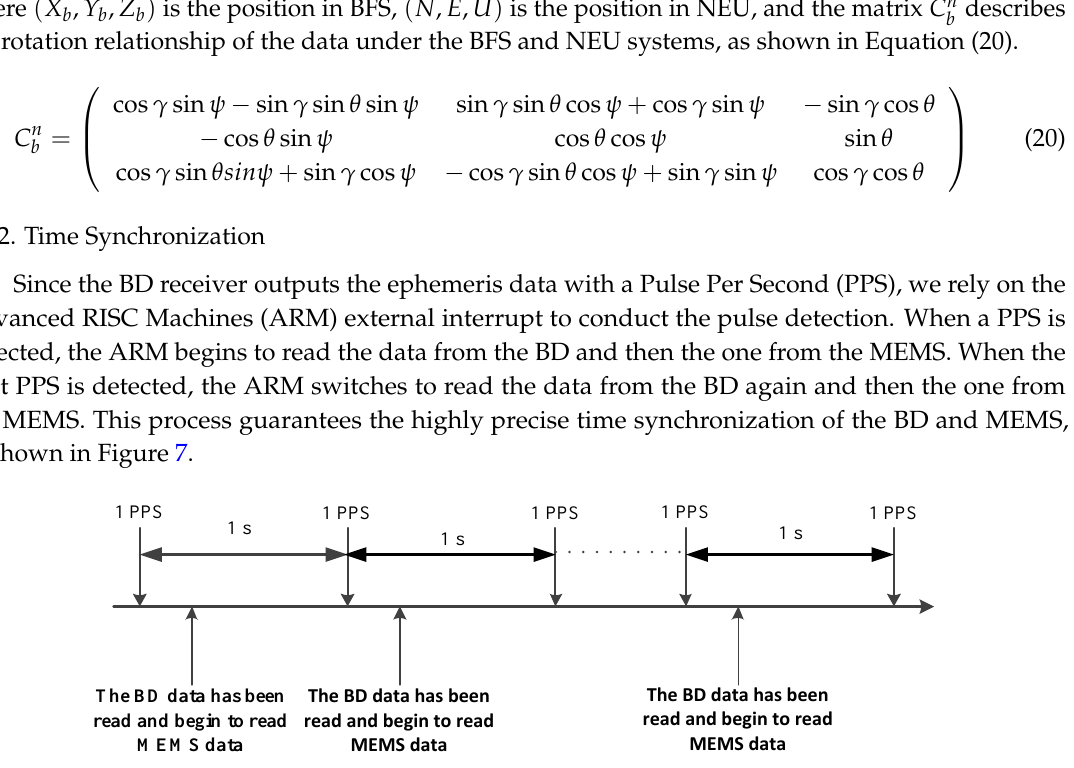
Figure 7. Process of time synchronization of the BD and MEMS. PPS: Pulse Per